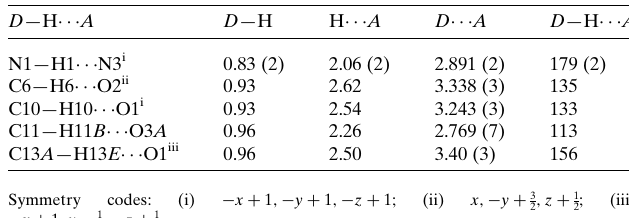
Table 1 Hydrogen-bond geometry (A˚ , (cid:3) ).